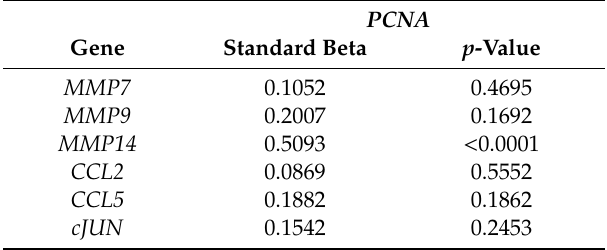
Table 2. The gene expression level of proliferating cell nuclear antigen ( PCNA ) was associated with the indicated genes using linear regression models adjusted for age and BMI in human prostate tissues (n = 56). Standard beta values represent standardized regression coefficients. Statistical significance was considered as p < 0.05.